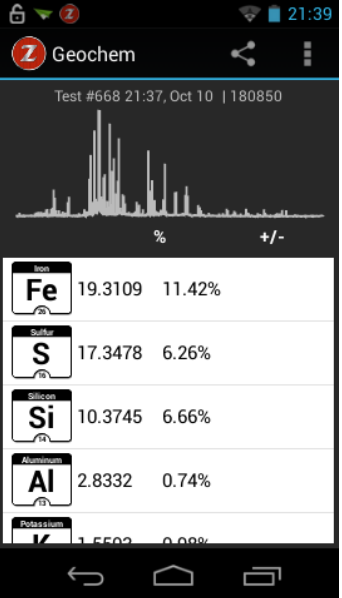
Figure 12. SciAps Z-300 screen display showing the quantitative analytical results for Fe, S, Si, and Al obtained after analyzer